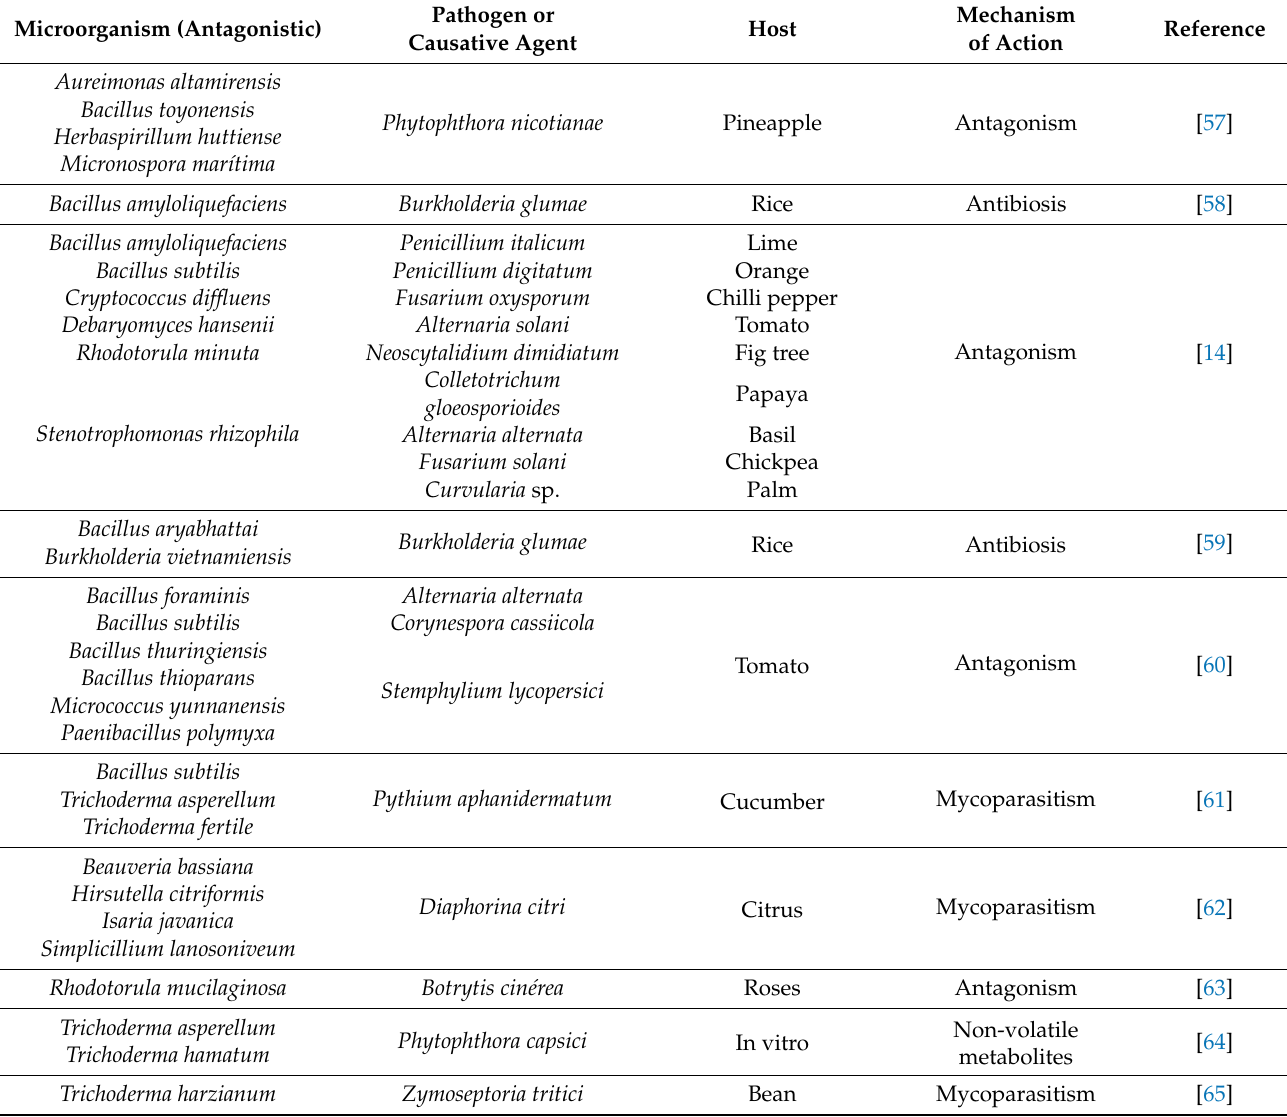
Table 1. Microorganisms used for the biocontrol of